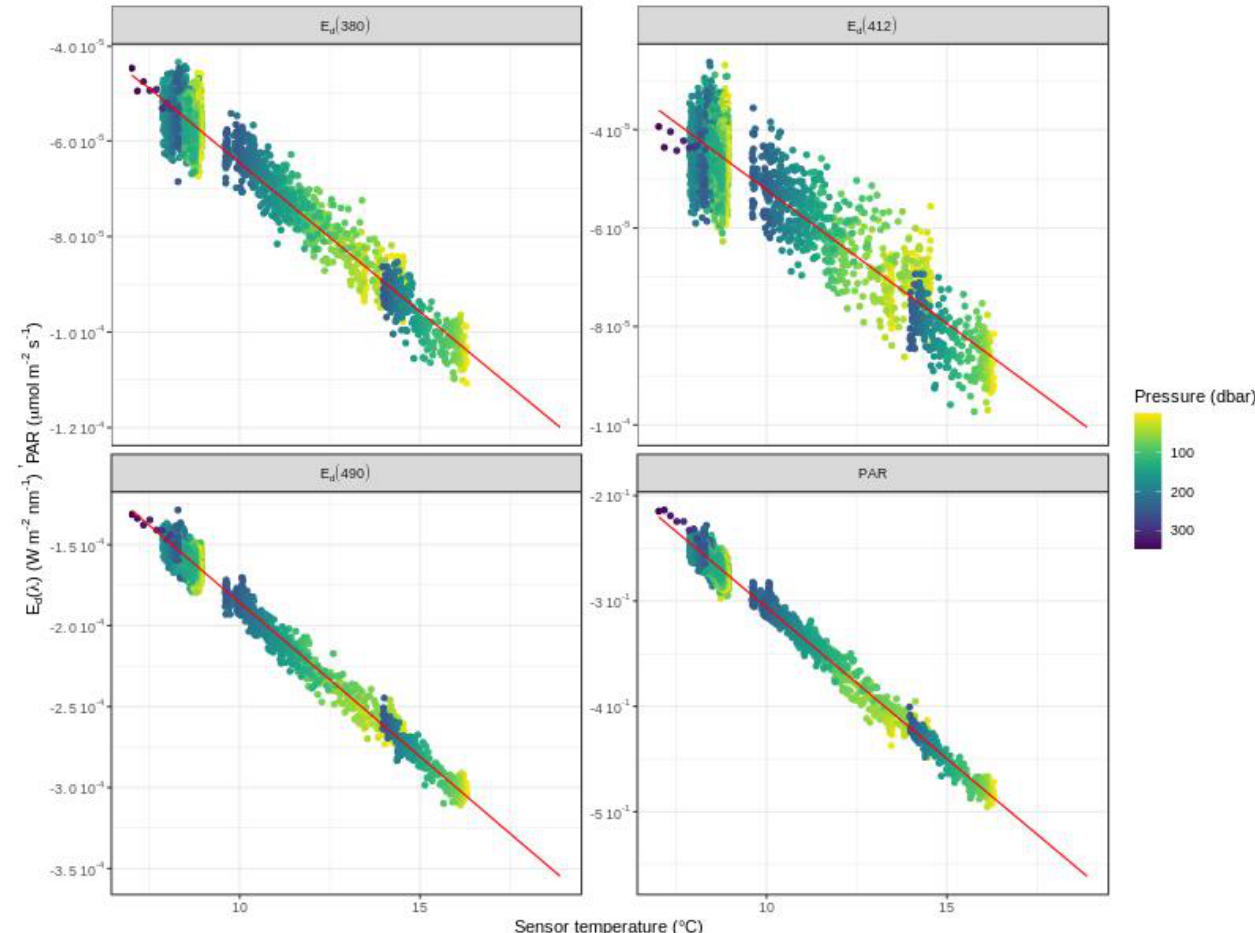
Figure 6. Radiometry night profiles of E d ( λ ) and PAR as a function of sensor internal temperature T s . Dots are colored according to pressure. Solid red line is the fit to all points, and is extrapolated to cover the entire range of temperature encountered by the float during the whole lifetime. Prior to computing the linear regression, night profiles have been corrected for any sensor aging. Example is shown for the float WMO6901584.